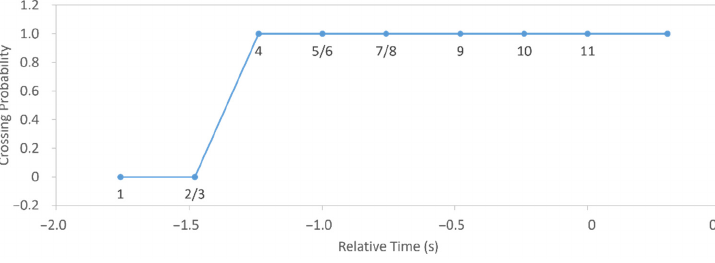
Figure 10. Pedestrian crossing intention prediction with relative time.